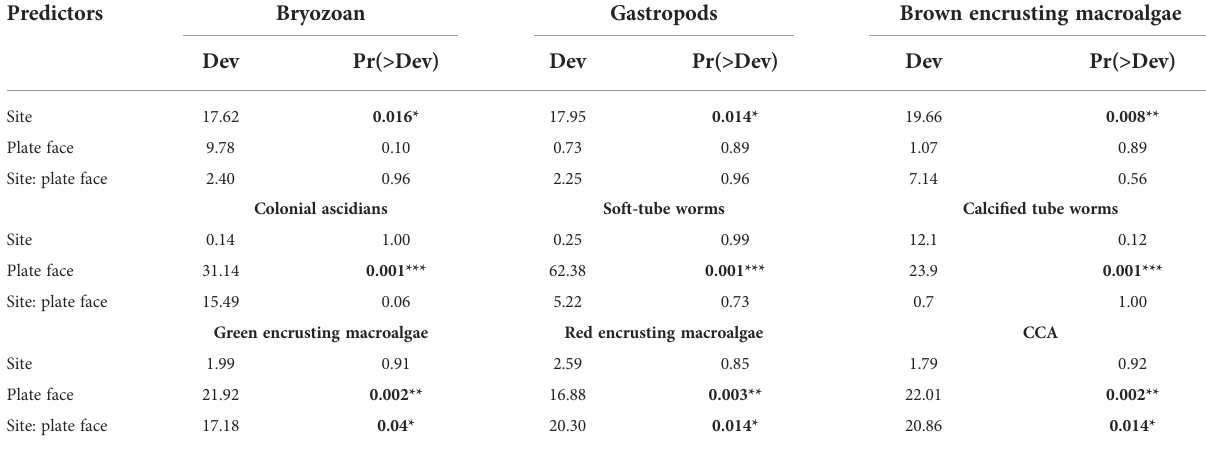
TABLE 2 Summary of the statistical signi fi cance of resampling-based univariate generalised linear models (GLMs) assessing the effect of site and plate face on the abundance of individual sessile groups.